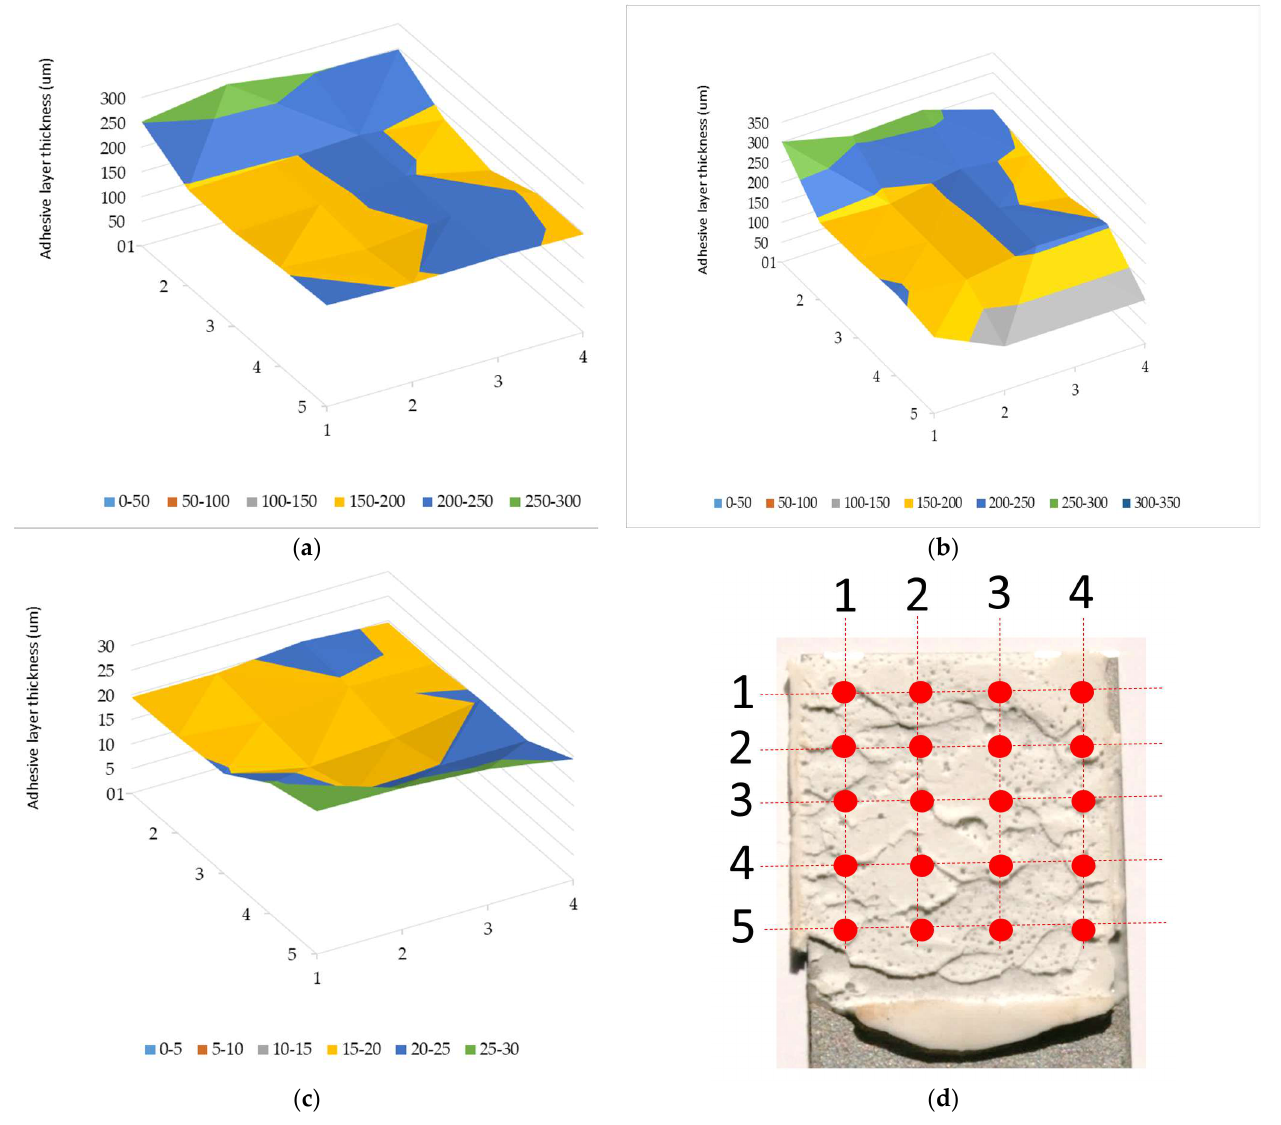
Figure 14. Adhesive thickness after joint shear test for: ( a ) first test series, ( b ) second series, ( c ) third test series, ( d ) the origin of the measurement points.